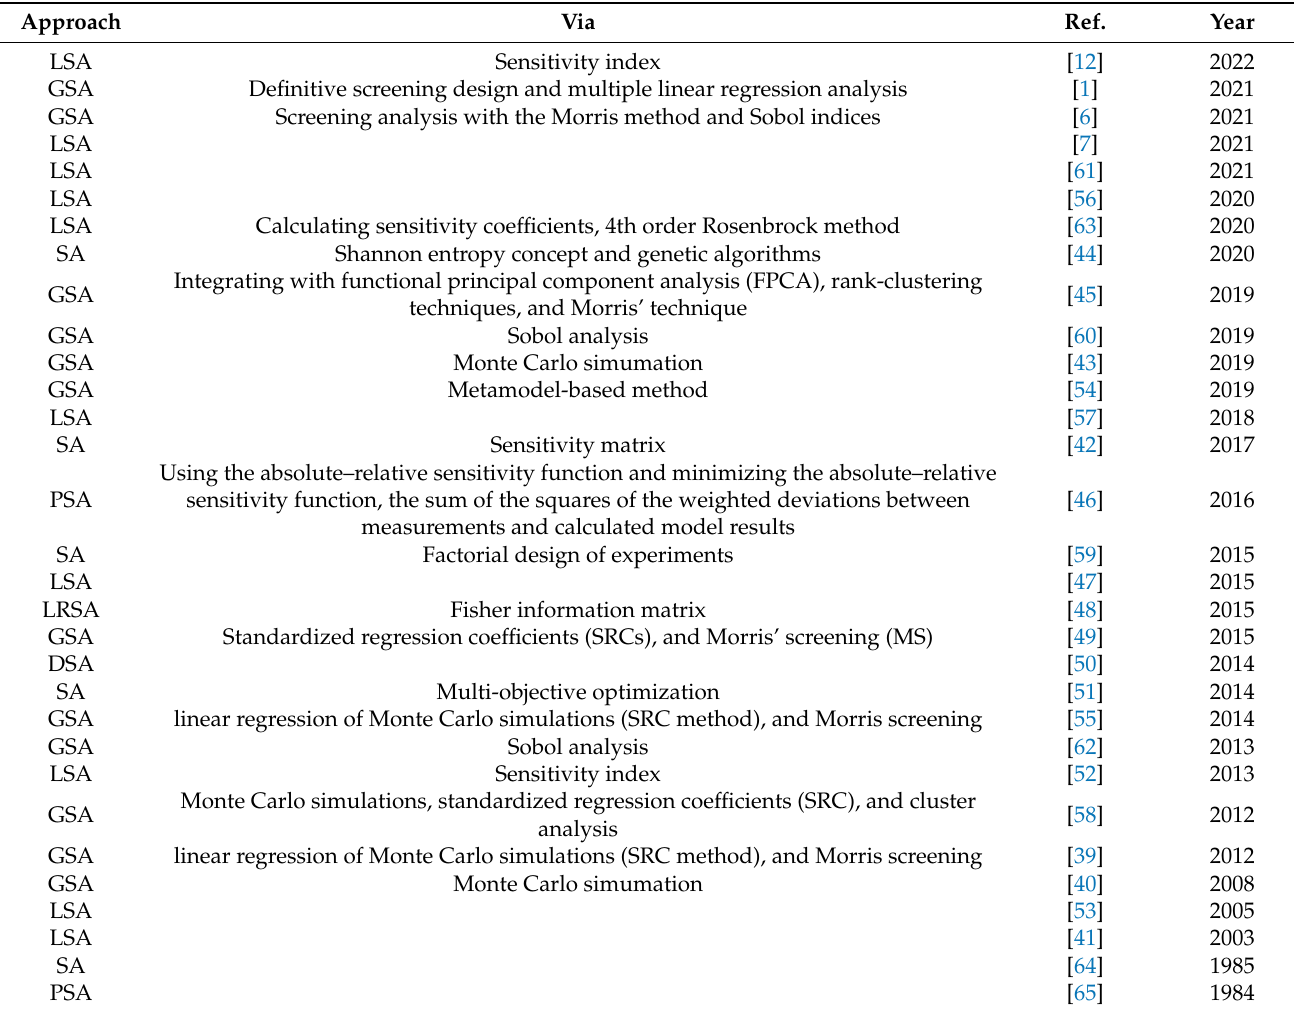
Table 3. Sensitivity approaches and methods used in analyses.